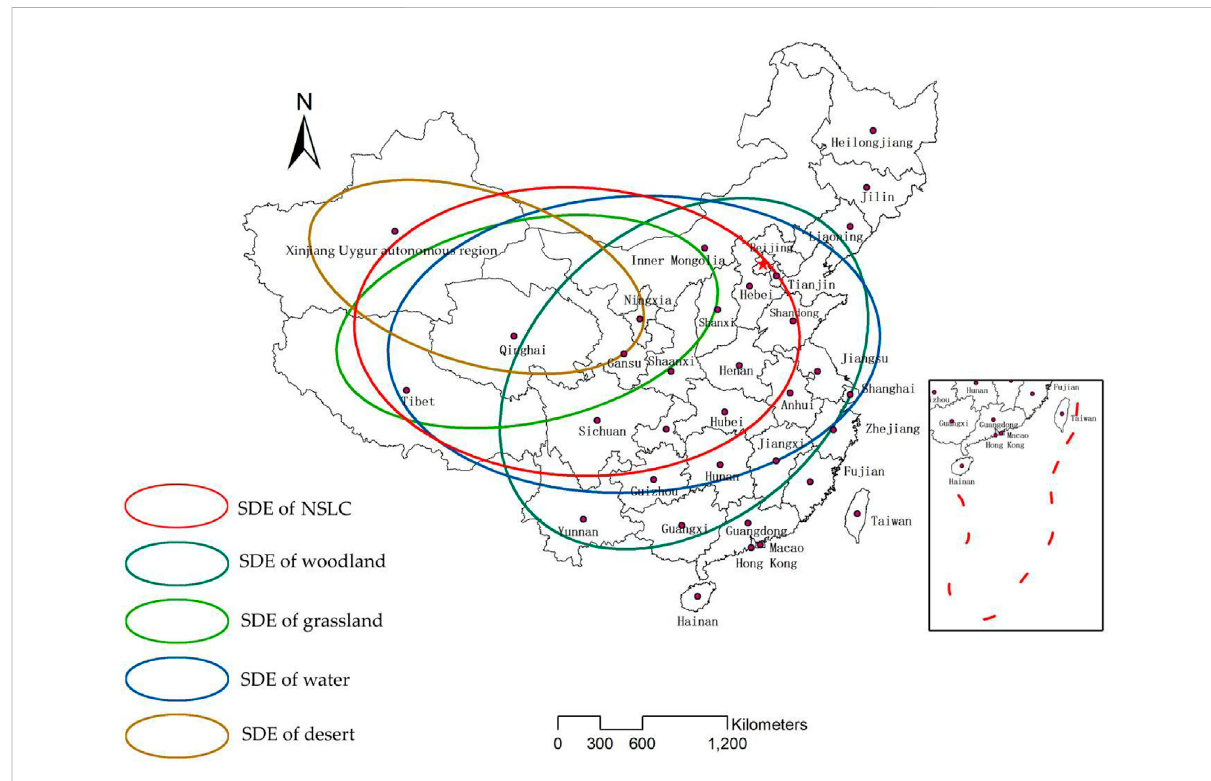
FIGURE 4 SDE spatial distribution of ecological space types in 2015.